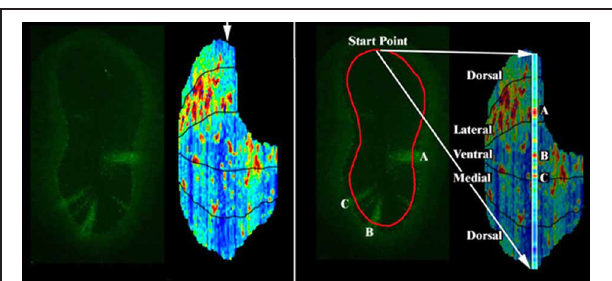
FIGURE 1 | Fluorescence intensity reconstruction method. To create a map of the position of labeled areas, the equivalent of a Mercator projection is constructed by stacking the coronal sections (Liu et al., 2004). Left: a sample coronal section from a PRV labeled OB, and full reconstruction of the fluorescence intensity in the GC layer just deep to the internal plexiform layer (IPL). Arrow indicates the position of the displayed section. Right: to make the full reconstruction, a line is drawn through the GC layer deep to the IPL for each coronal section. Pixel intensities along this line are captured. Each of these colored sections is then computationally scaled and arranged according to their anatomical positions to map the pixel locations onto a 2D surface. The displayed section is expanded at right showing columns A , B , and C respectively.